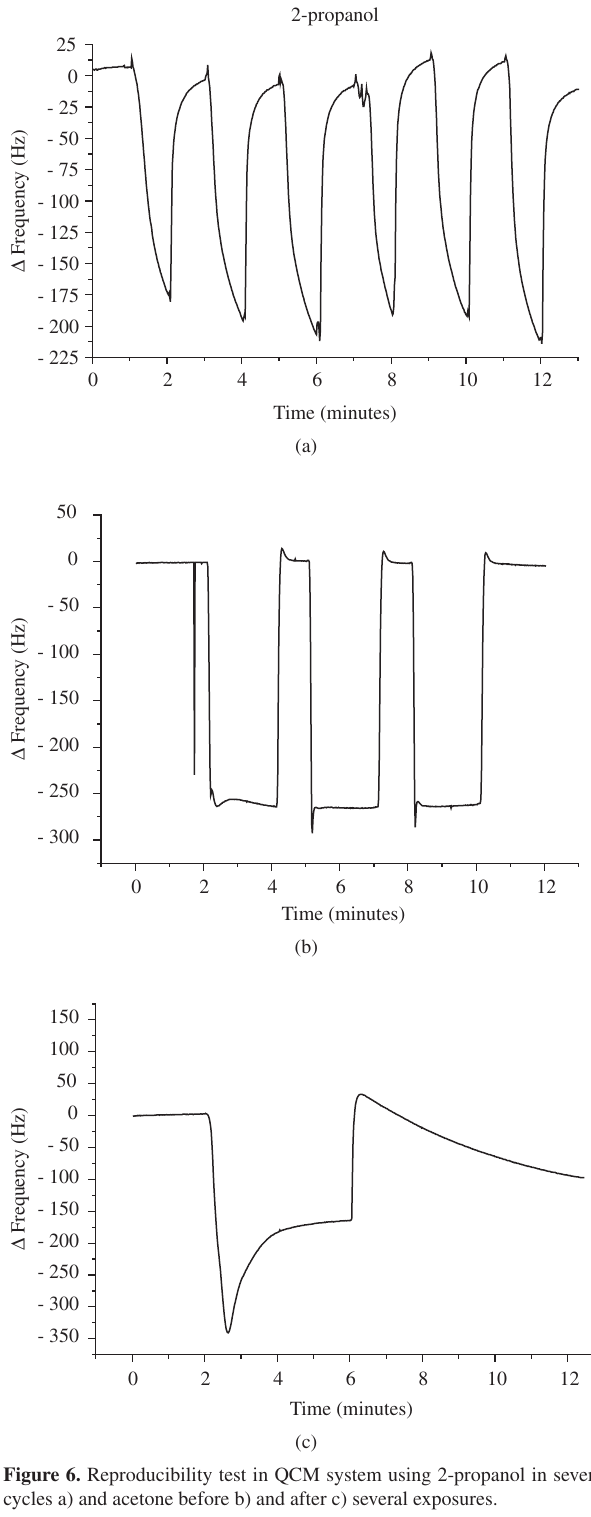
Figure 8. Untreated and treated grains after 3 weeks exposure in a humid environment.